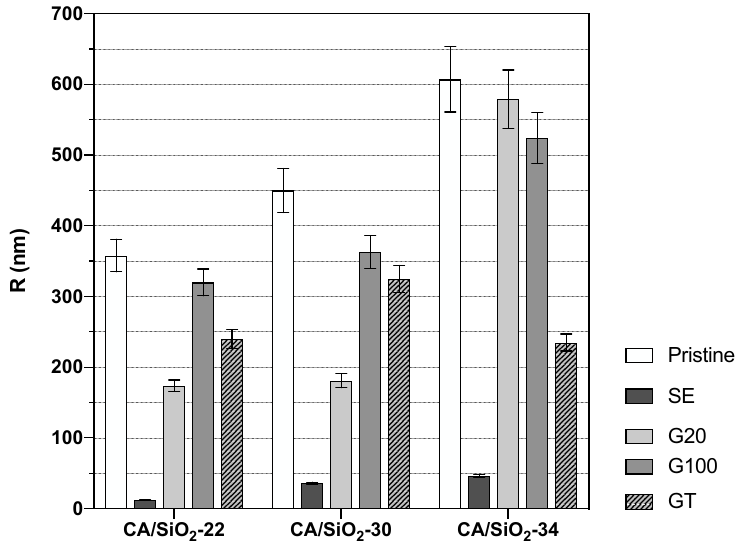
Figure 10. Average radial length of the water channels determined from the DNMR relaxation times T 1 and T 2